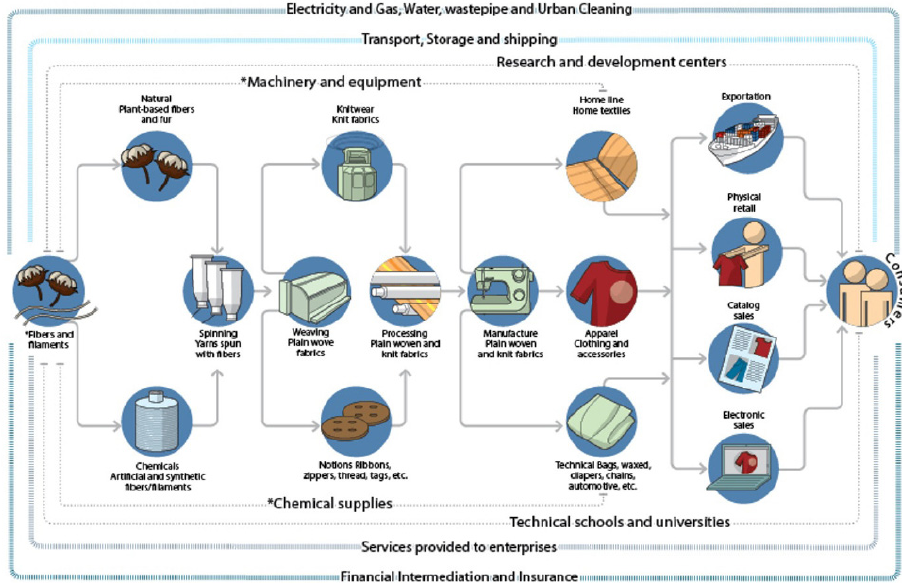
Figure 1. Structure of the textile and apparel production and distribution chain.